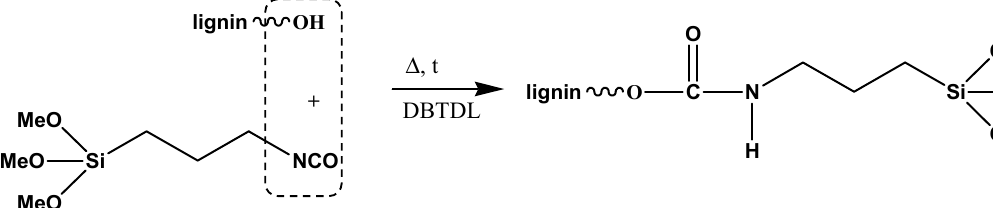
Figure 15. Schematic representation of the silanization of lignin. Adapted from [67], with permission from American Chemical Society and Copyright Clearance Center, 2019.